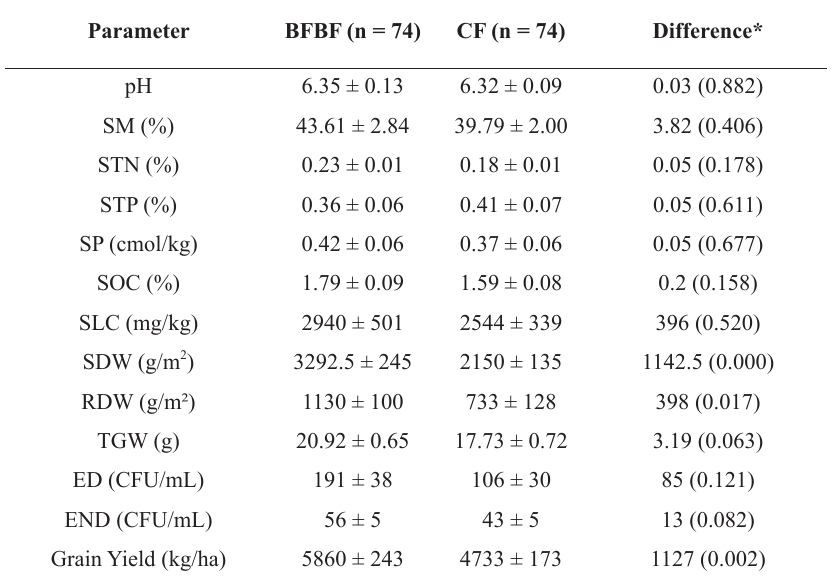
Table 1 : Rhizosphere soil, plant and microbial parameters of the BFBF practice and farmers’ CF practice of rice cultivations. Plant and soil samples were collected at 50% flowering whereas yield parameters were obtained at physiological maturity.